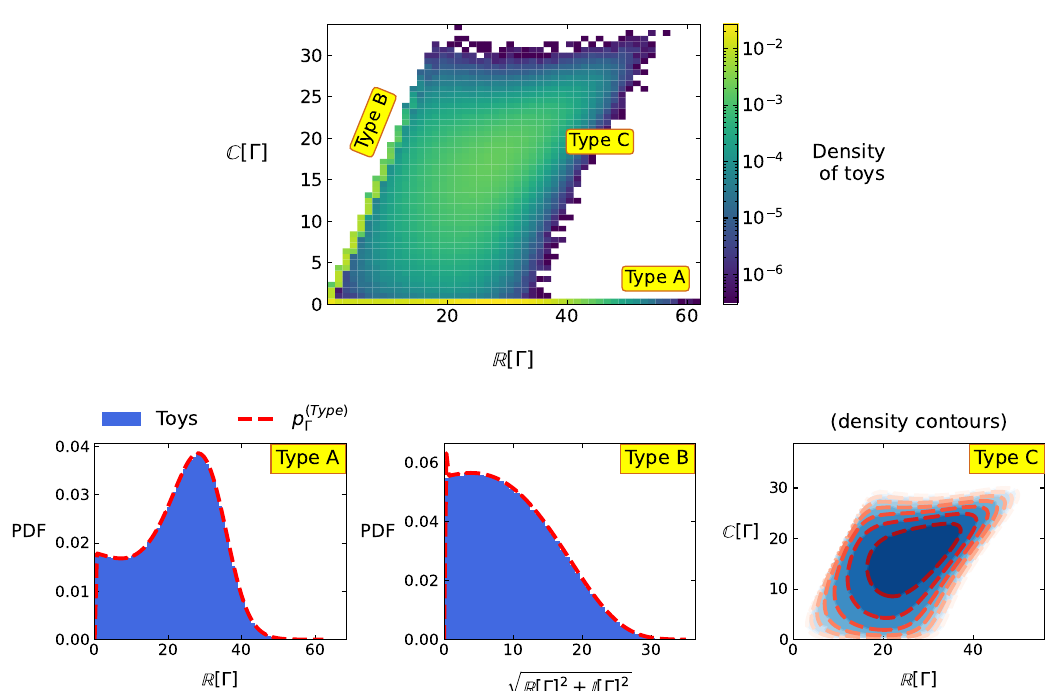
Figure 24: Top: density of Γ in the complex plane estimated using toys. Three differ- ent modes are visible and designated types A, B and C. Bottom: comparison between the the toys (blue histogram) and evaluated PDF (red line) for the three modes. ) -pair. In Fig 24(bottom left and middle) we see that these formu- solution for any given ( Γ , ∆ 0